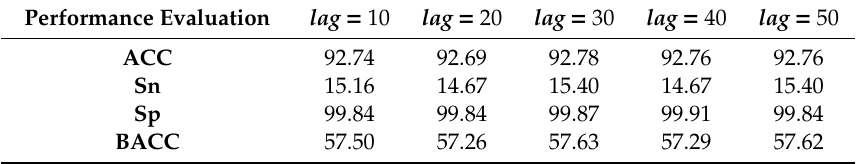
Table 5. The prediction overall accuracy of ECM proteins by selecting di ff erent lag